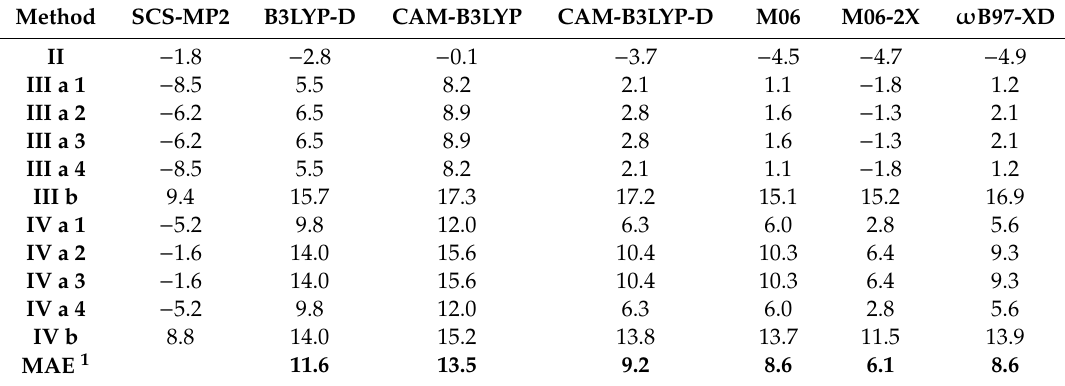
Table 4. Summary of the reaction energies ( ∆ E reac ) of possible reaction products for the reaction of the nitrile derivative with methanethiol (Scheme 3, Table 3). All calculations were performed with 6-311 ++ G(d,p) basis sets [57] in combination with the C-PCM approach (solvent = water) to mimic environmental e ff ects. The structures were previously optimized with ω B97-XD / 6-311G(d,p) [58]. All energy values in kcal /